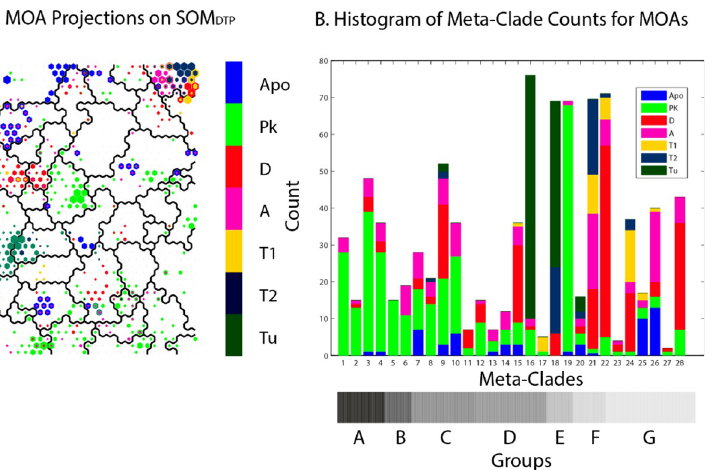
Fig 5. Panel A: SOM DTP projections for FDA approved compounds for the primary CellMiner assigned MOAs. Projections include the top 10 th percentile of SOM DTP nodes for each compound. Panel B: histogram of the counts for these primary MOAs across SOM meta-clade groups. Primary MOAs appear color-coded in each vertical bar, with their heights corresponding to MOA counts in each meta-clade. Horizontal grayscale bar below Panel B indicates meta-clade groups A : G (reproduced from Fig 2 Panel A ).